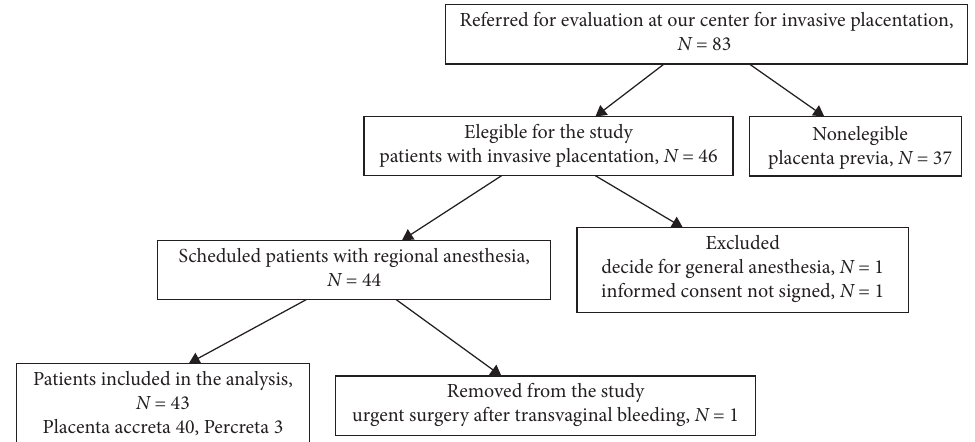
Figure 4: Study profile.